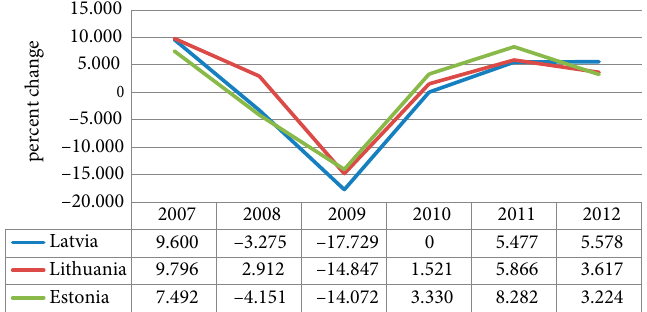
Fig. 1. Gross domestic product at the constant prices, the percent change in the Baltic states Source : drawn up by the authors with reference to the data of International Monetary Fund (2013)